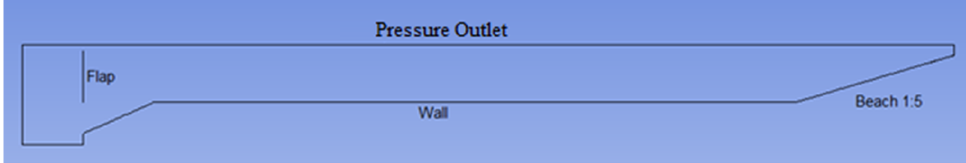
Figure 6. Geometry and boundary condition of the numerical wave tank.